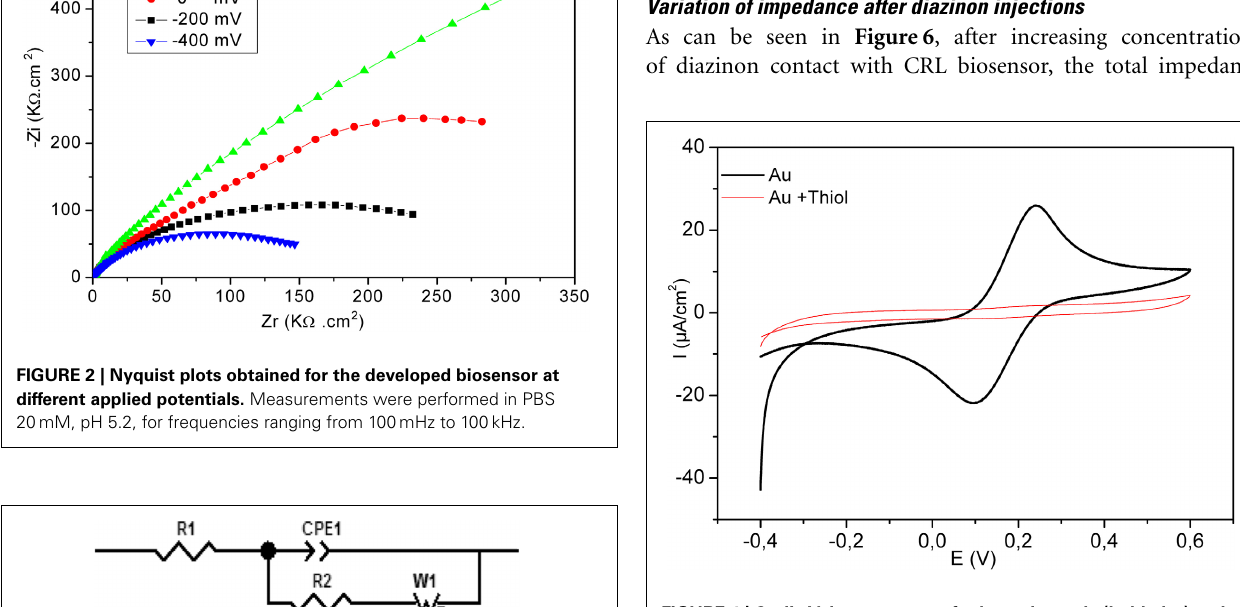
FIGURE 4 | Cyclic Voltammograms for bare electrode (bold plot) and for modified electrode by thiol (thin line). Measurements were performed in 8mM Fe (CN 6 ) 3 − / 4 − , scan rate